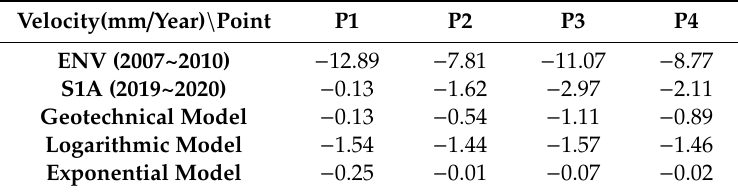
Table 2. The vertical deformation velocities obtained by the ENV SAR data from 2007 to 2010, the vertical deformation velocities obtained by the S1A SAR data from 2019 to 2020, and the vertical deformation velocities estimated by three models from 2019 to 2020 at four pixels labeled as P1, P2, P3, and P4. Velocity(mm / Year) \ Point P1 P2 P3